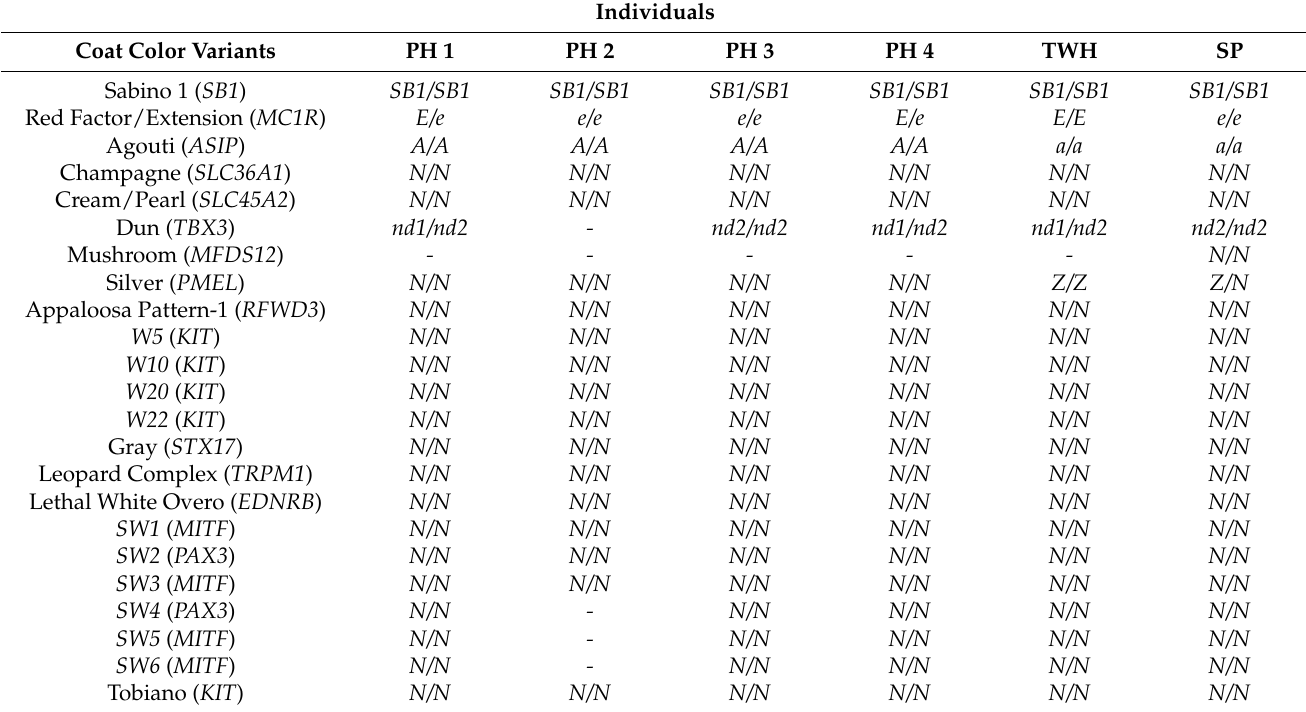
Table 3. Individuals homozygous for KIT variant sabino 1 ( SB1 ) with their respective breeds and genotypes for other coat color variants analyzed in this study. A dash indicates that genotyping for that locus was not performed for that individual. PH = Paint Horse; TWH = Tennessee Walking Horse; SP = Shetland